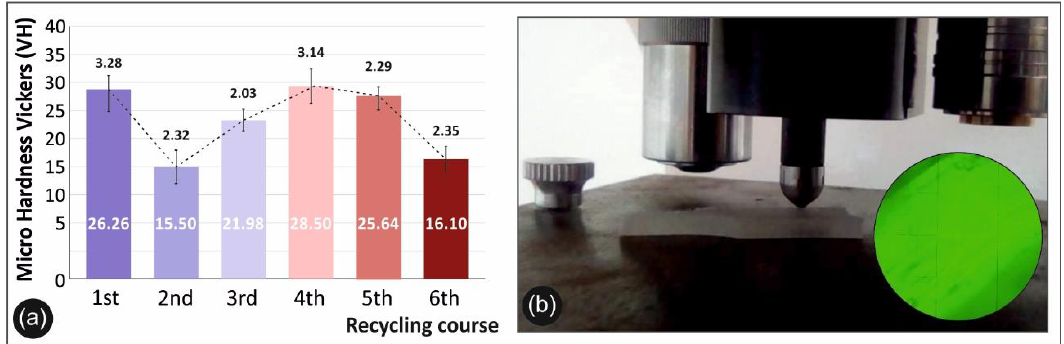
Figure 7. Micro-hardness Vickers tests: ( a ) comparison of the Vickers micro-hardness average values along with the calculated deviation from each recycle course studied and ( b ) device experimental setup and specimens after the test.